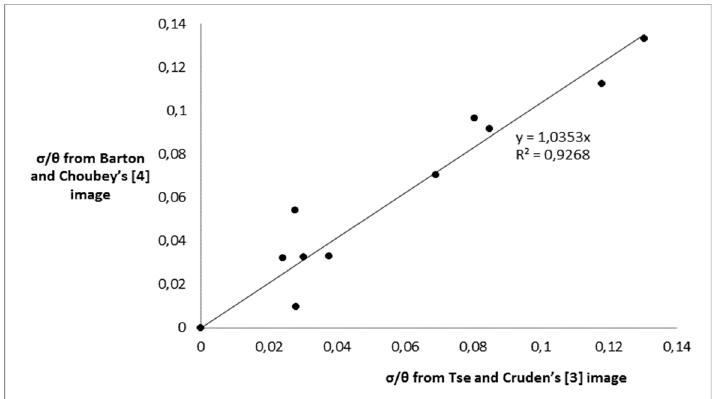
Figure 6. Graph comparing the logZ 2 values obtained from Tse and Cruden’s [3] and Barton and Choubey’s [4] image.